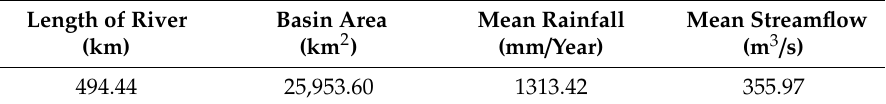
Table 1. Summary of site characteristics.